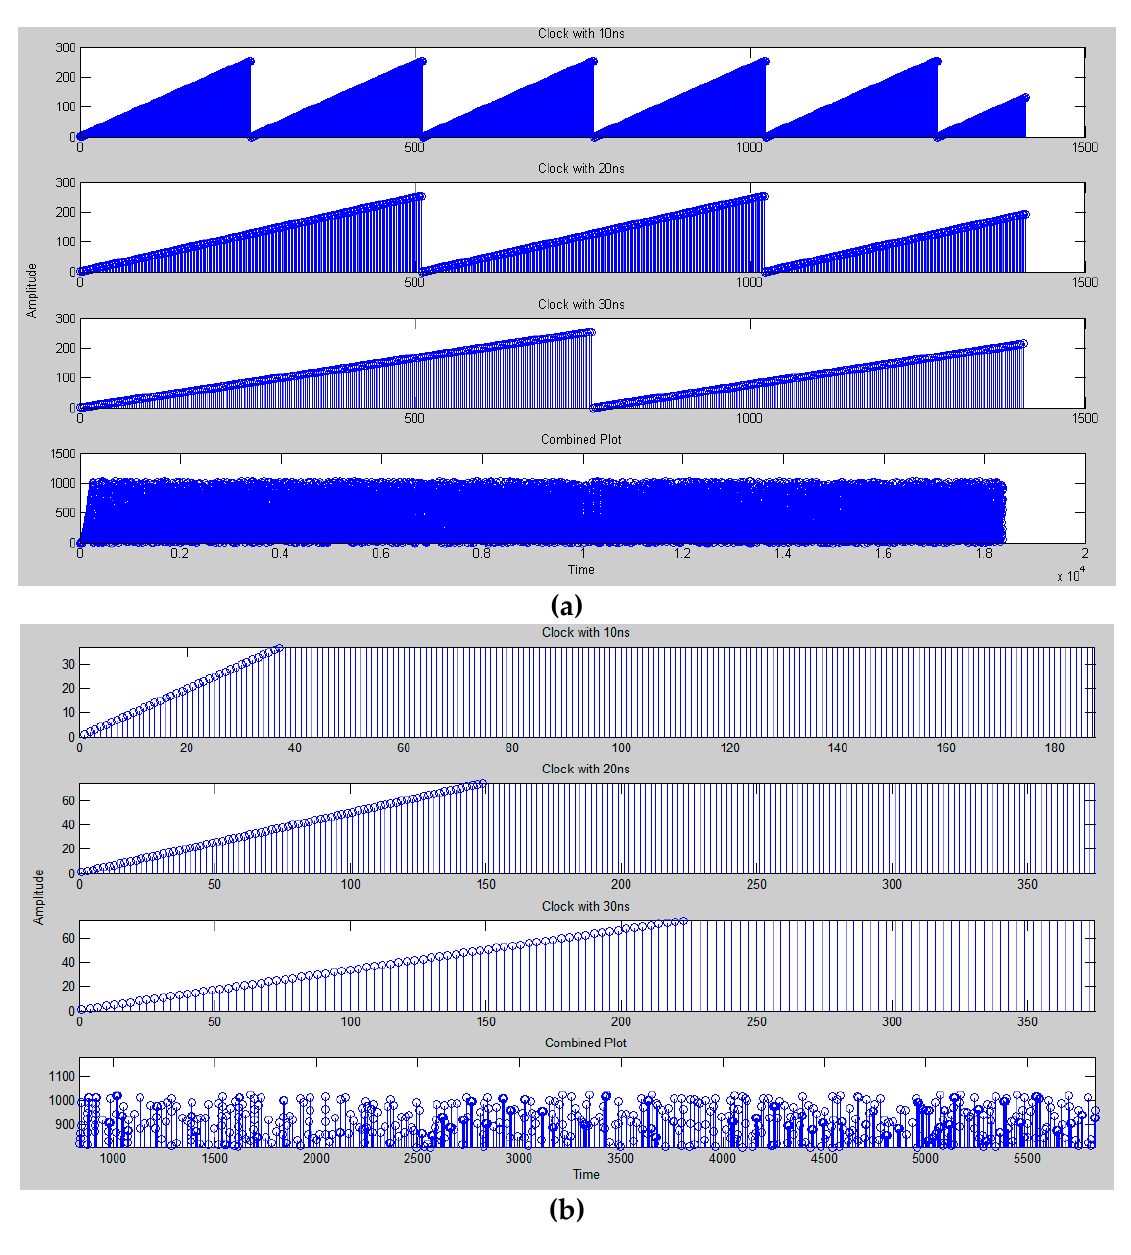
Figure 10. ( a ) Simple View. ( b ) Expanded View-Normal Communication between PEs.